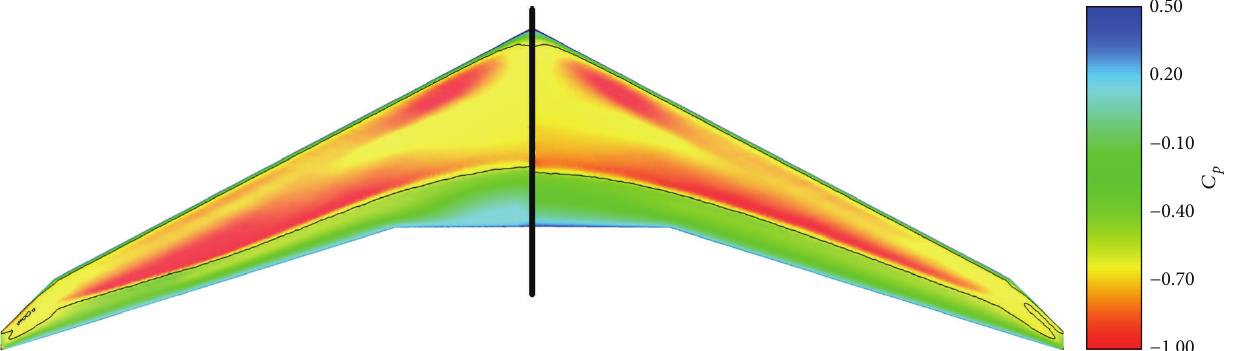
Figure 18: Comparison between the 𝐶 𝑝 distributions at cruise Mach over the reference wing (right) and over the wing equipped with morphing trailing edge